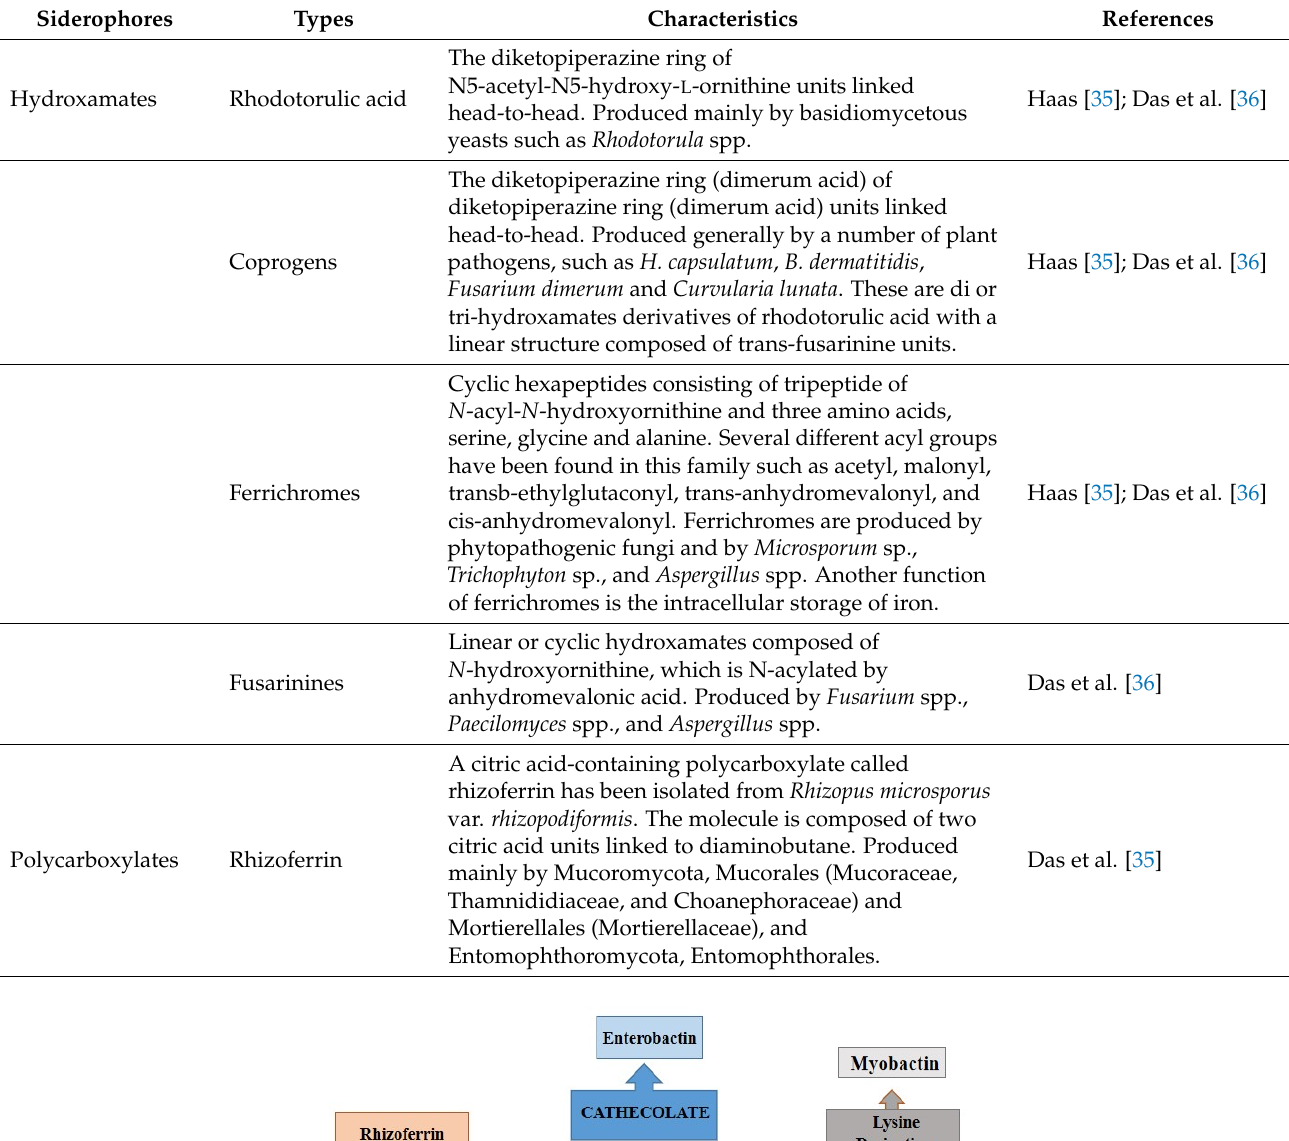
Table 1. Types of siderophores and their characteristics.